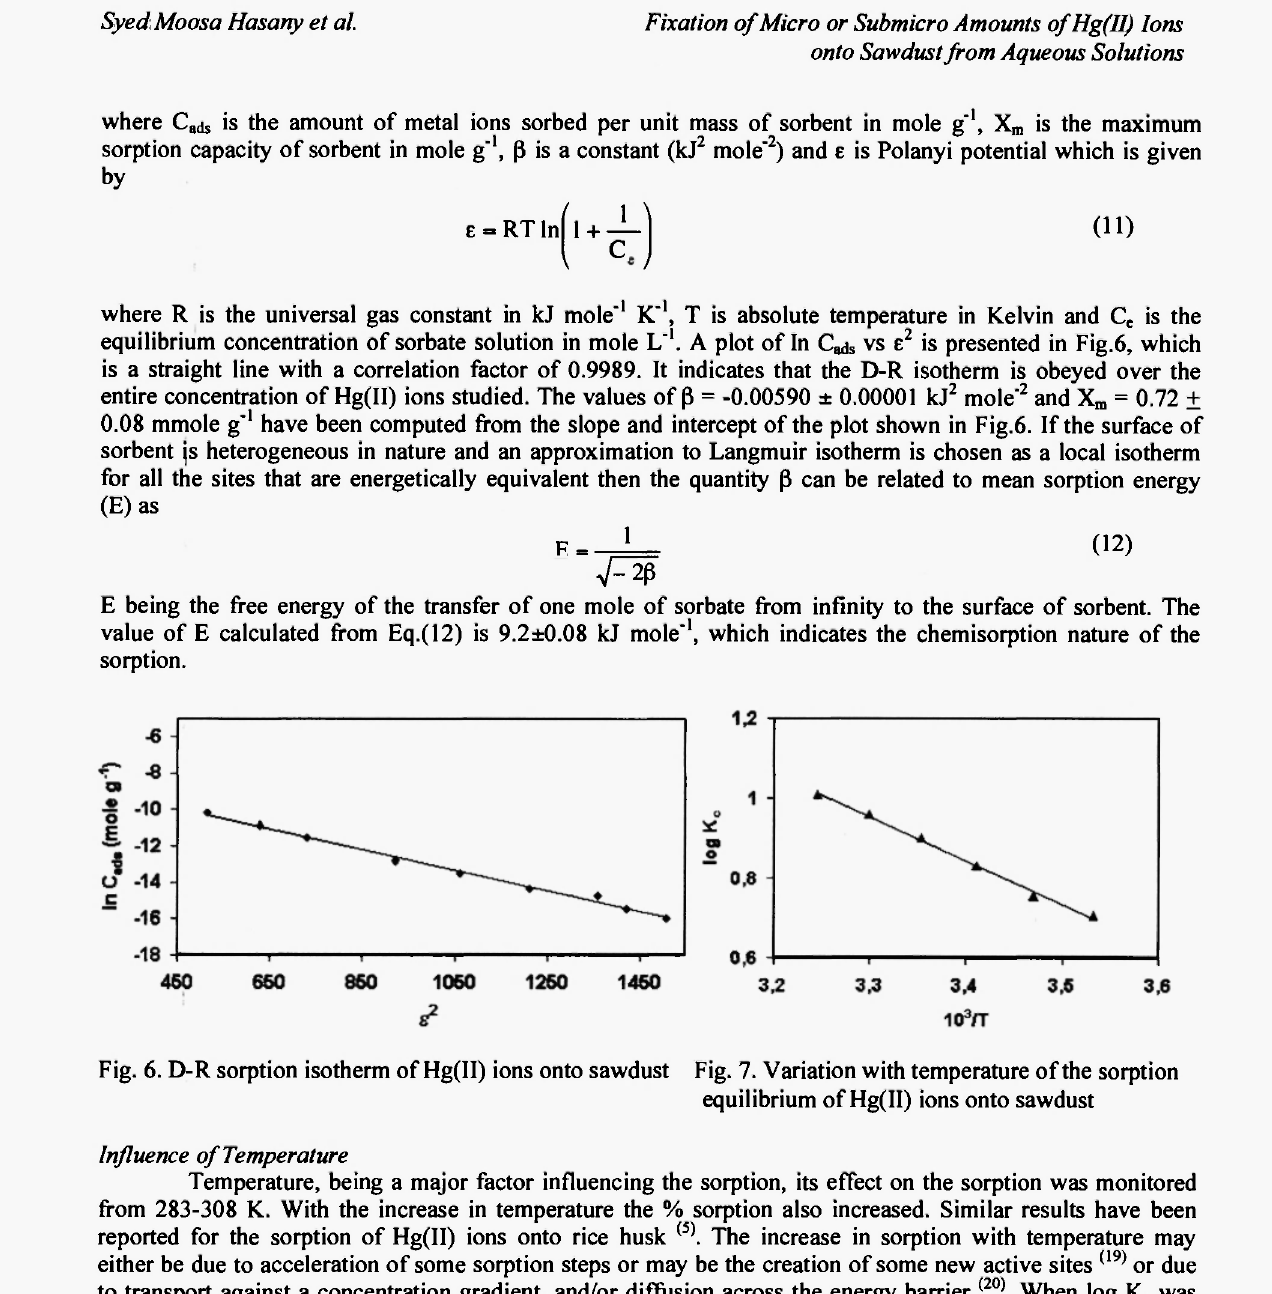
Fig. 6. D-R sorption isotherm of Hg(II) ions onto sawdust Fig. 7. Variation with temperature of the sorption equilibrium of Hg(II) ions onto